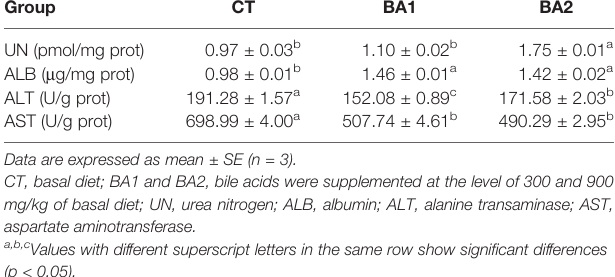
TABLE 6 | Effects of dietary bile acids on the activity levels of protease, lipase, and amylase in liver in tongue sole.